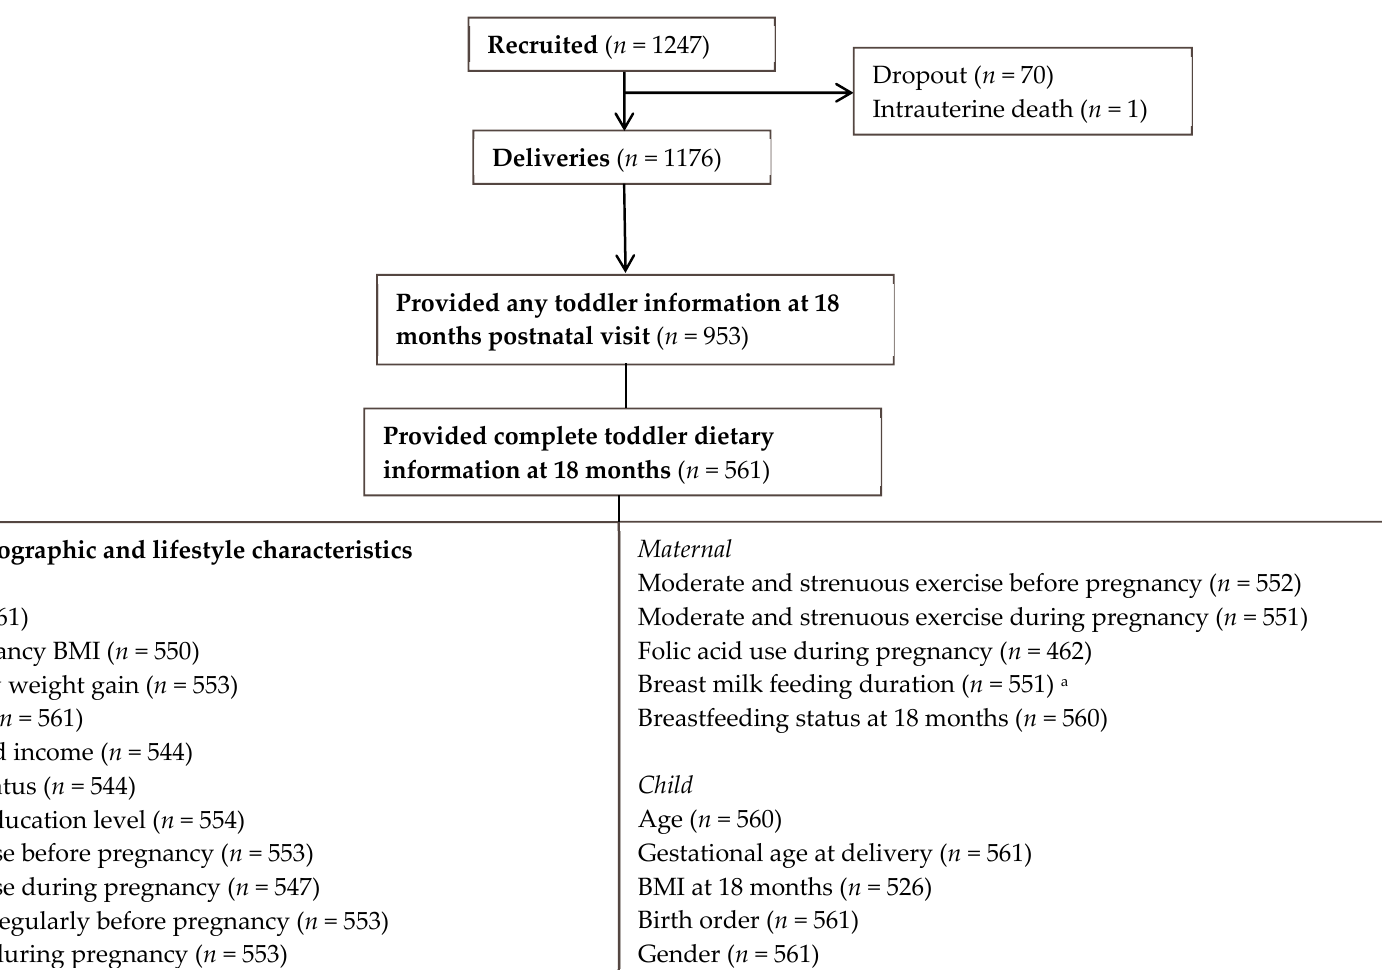
Figure 1. Flowchart of study participants. a Breastmilk feeding duration was assessed between delivery and 18 months postnatal visit.